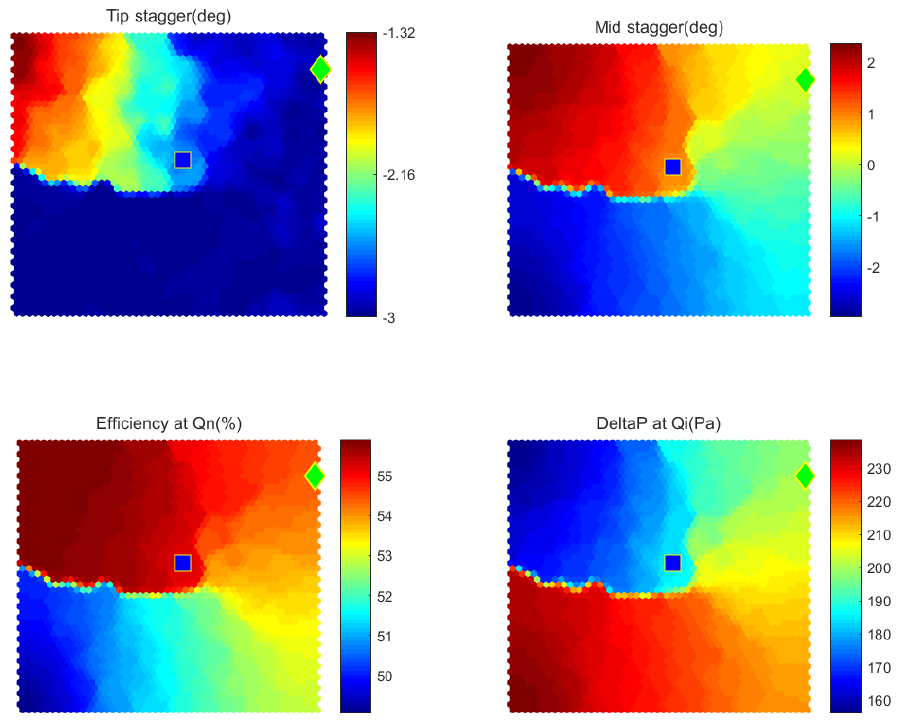
Figure 11. SOM visualization of Pareto front, optimA (green diamond point) and optimC (blue square